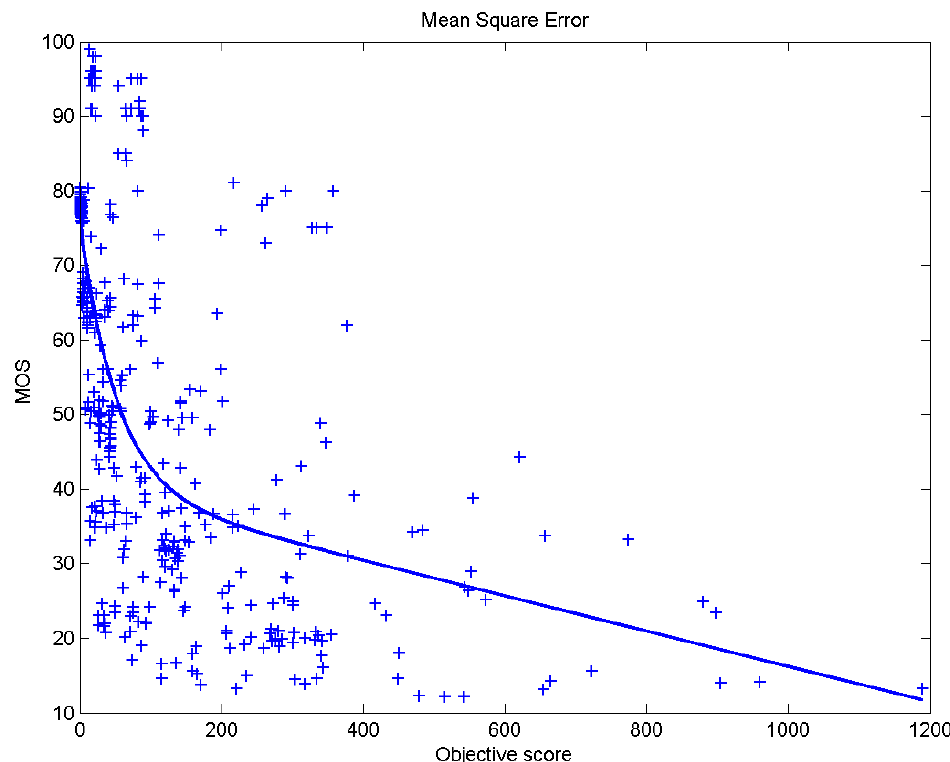
Figure 15. Scatter plots of the subjective scores (MOS) vs. MSE.